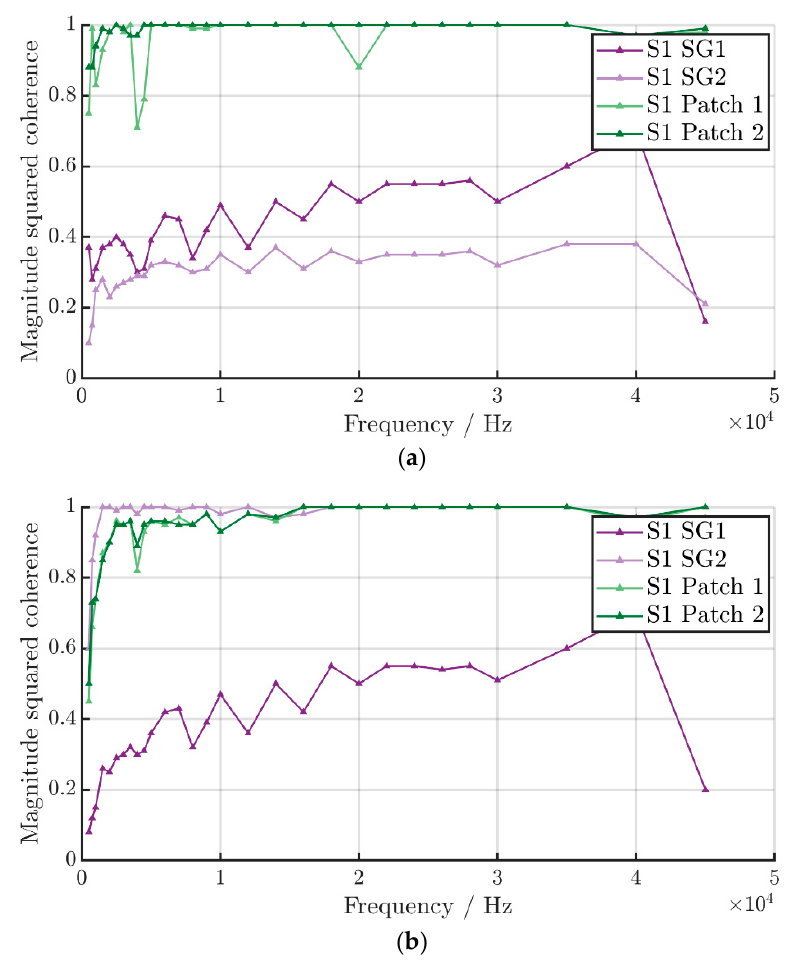
Figure 9. Coherence of the sensor signals of ( a ) Sheet 1 and ( b ) Sheet 2.